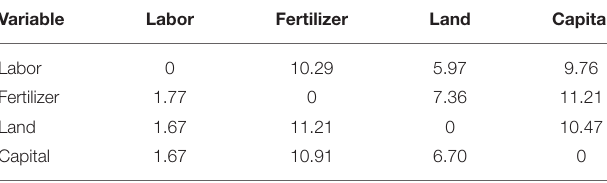
TABLE 6 | Morishima price elasticities of factor substitution. Variable